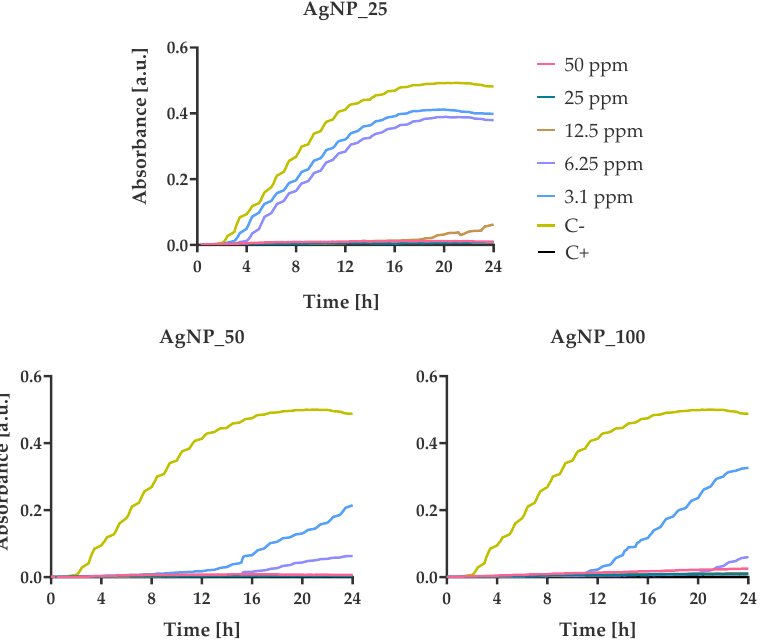
Figure 8. Growth kinetics of S. aureus in the presence of different concentrations (from 3.125 to 50 ppm) of AgNPs. Optical density was measured for 24 h at 37 °C using a multi-detection microplate reader at 600 nm and automatically recorded for each well every 15 min. In all experiments, the bacterial suspension in pure MH-B and in the presence of amoxicillin/clavulanic acid (50 ppm) were taken as negative and positive control respectively. S. epidermidis is the strain that presented the highest sensitivity of all four tested bac- teria against all three AgNPs samples. The incubation of S. epidermidis with all tested con- centrations led to a bactericidal effect against S. epidermidis cells during the first 24 h (Fig- ure 9). These results are in good agreement with the morphological observation by SEM images showing the complete damage of the bacterial cell membranes (Figure 5).